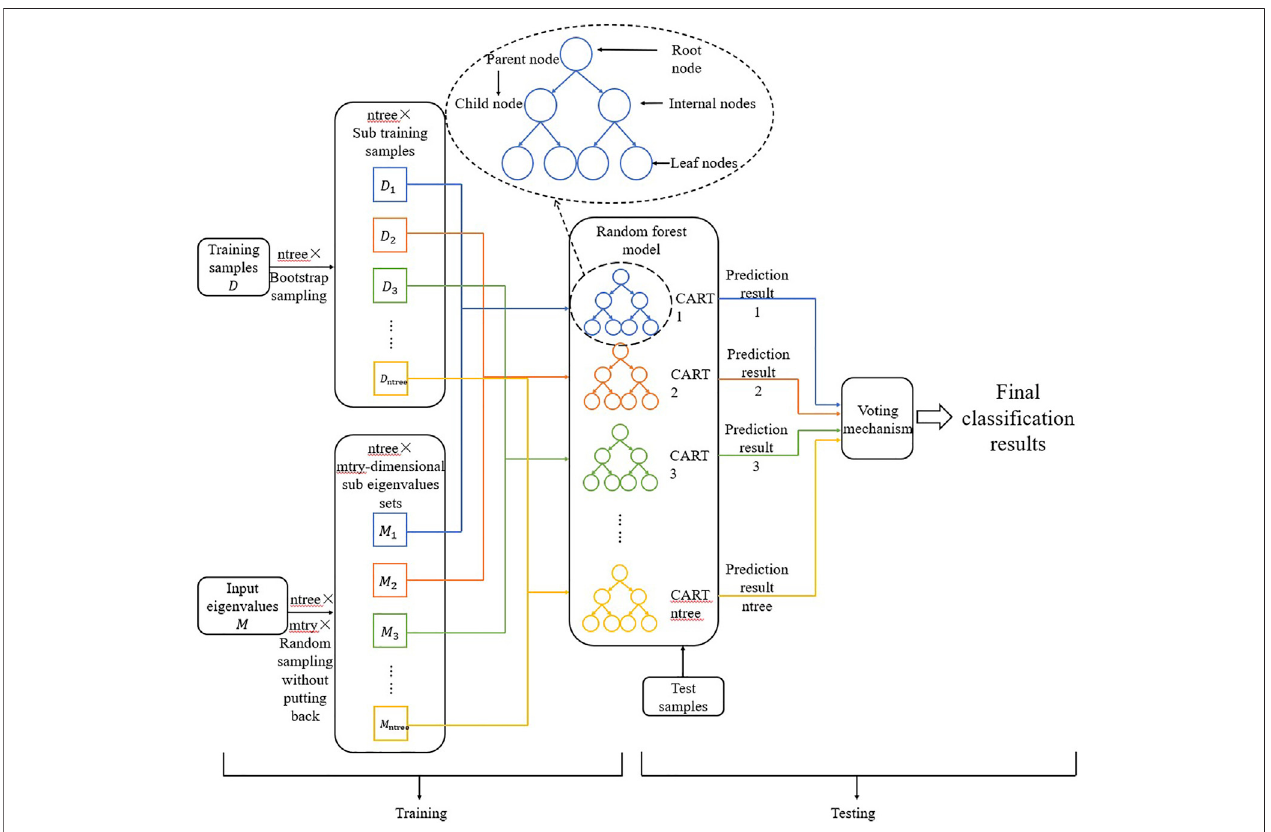
FIGURE 9 | Flow diagram of the random forest